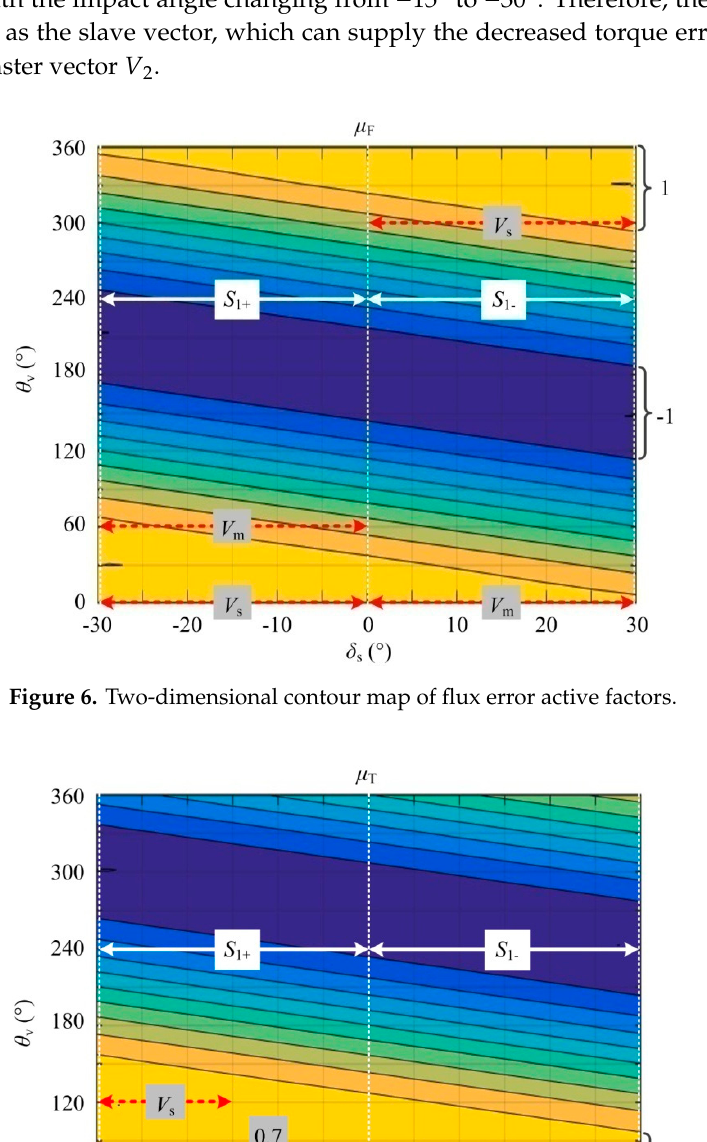
Figure 8. Two-dimensional contour map of flux error active factors.